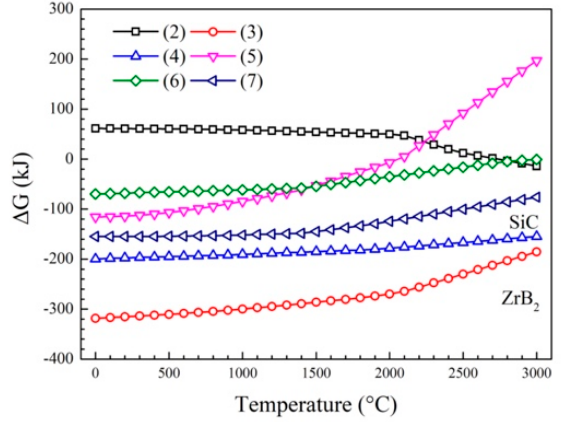
Figure 2. Δ G-T curve of the reactions. Figure 2. ∆ G-T curve of the